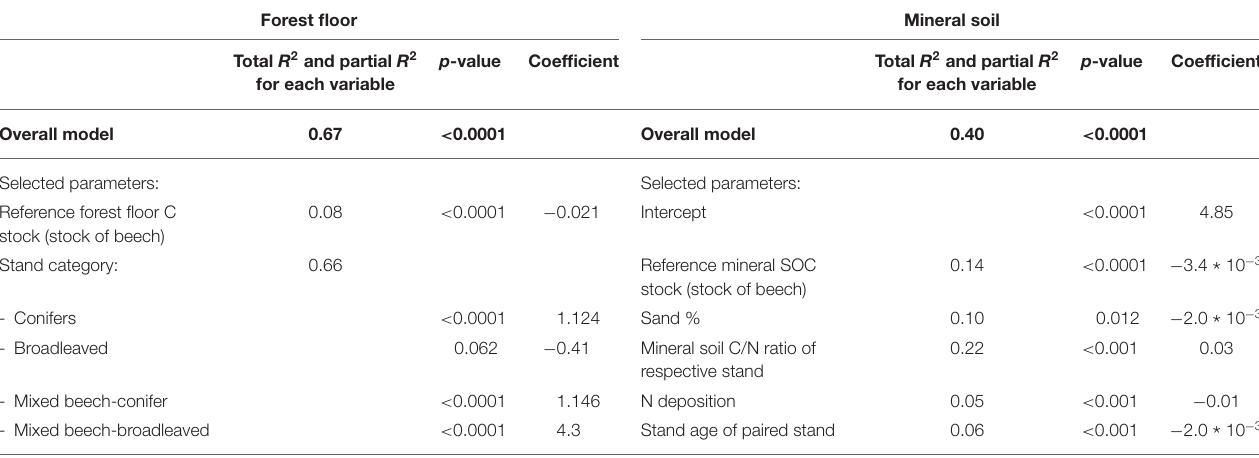
TABLE 2 | Results of the multiple stepwise regression analyses to identify the factors driving the differences in organic C stocks of other tree species/mixtures compared to beech in the forest floor and the mineral